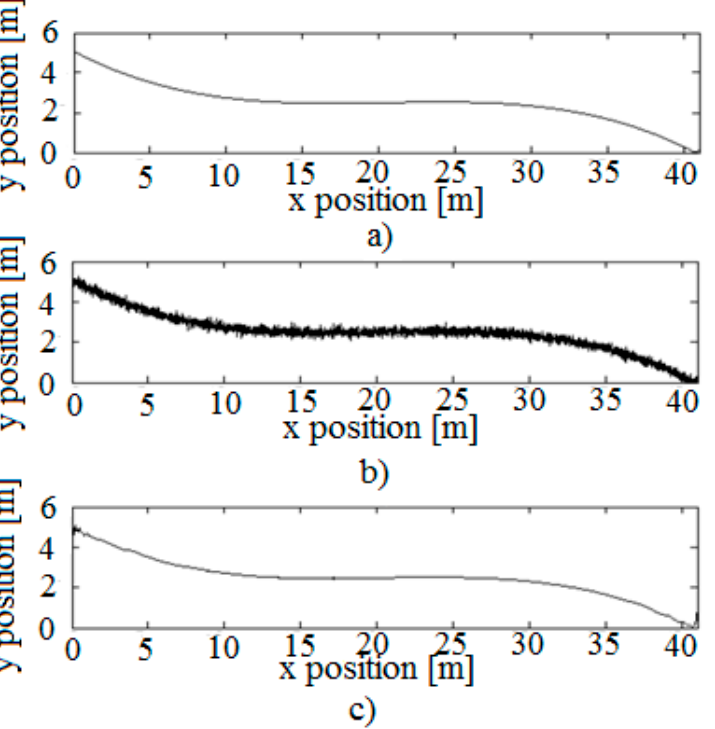
Figure 6. Results of the fourth experiment with simulated data: ( a ) third order polynomial trajectory; ( b ) waveform of the result obtained after the simulated tracking; ( c ) the effect of the wavelet-based polynomial fitting method.